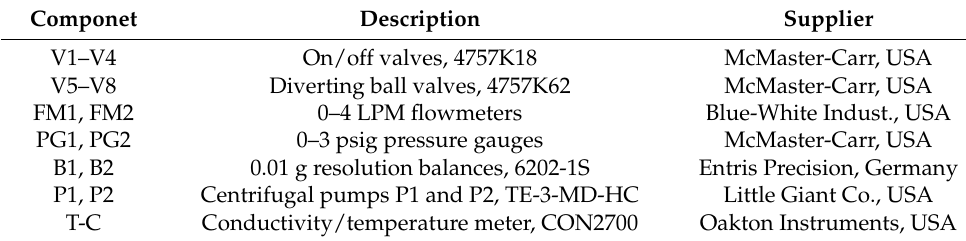
Figure 2. Schematic diagram of the FO testing setup. Adapted with permission from Ref. [20]. 2020, Elsevier. Table 1. Specifications of the components in the FO testing